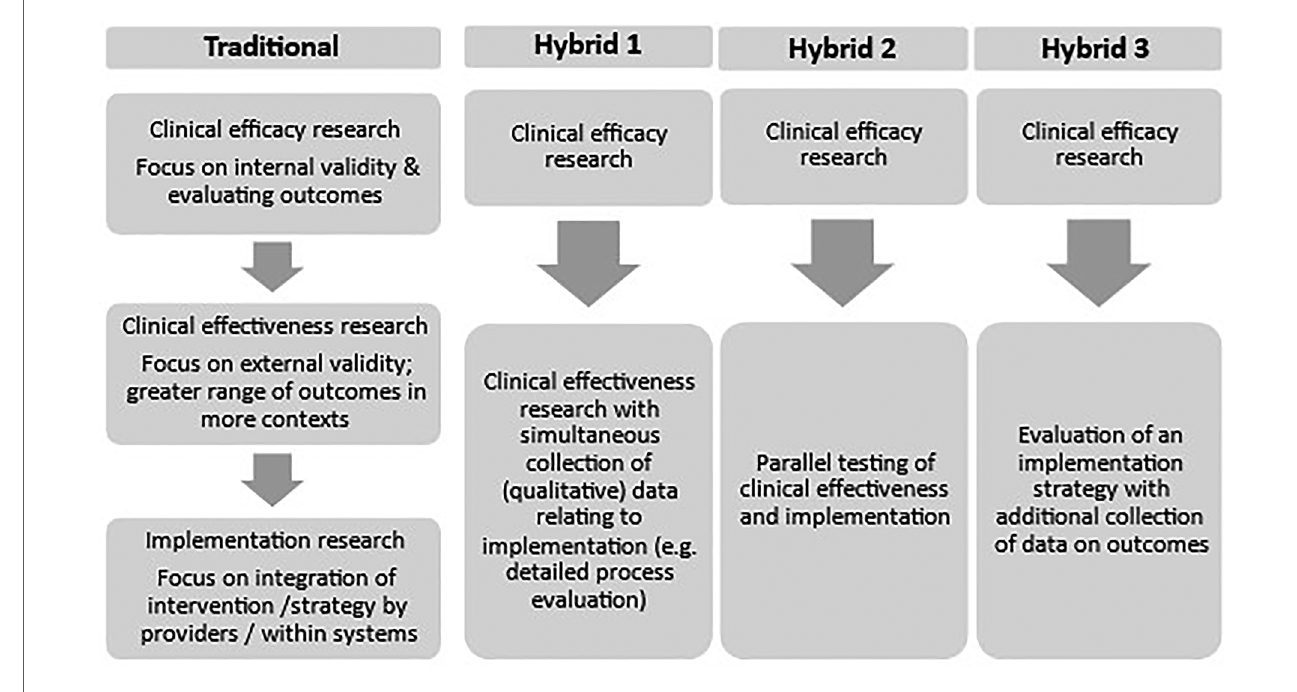
FIGURE 2 Summary of a traditional model of progression from clinical ef fi cacy to clinical effectiveness and implementation research and three proposed effectiveness- implementation hybrid designs [based on information from Curran et al